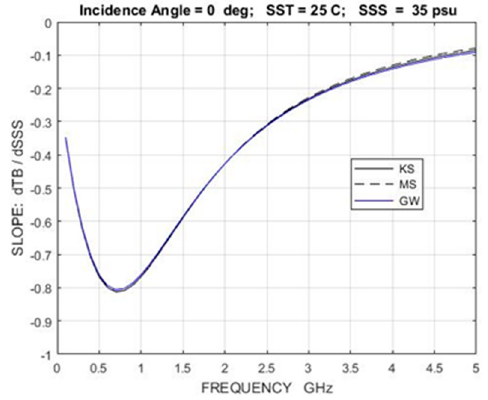
Figure A2. Comparison of the sensitivity, dTB/dSSS, computed with the three model functions for the dielectric constant of sea water: KS = Klein-Swift [19]; MW = Meissner-Wentz [34]; GW = Zhou et al. [35]. These examples are for SST = 25 ℃ and SSS = 35 psu and no wind (flat surface).